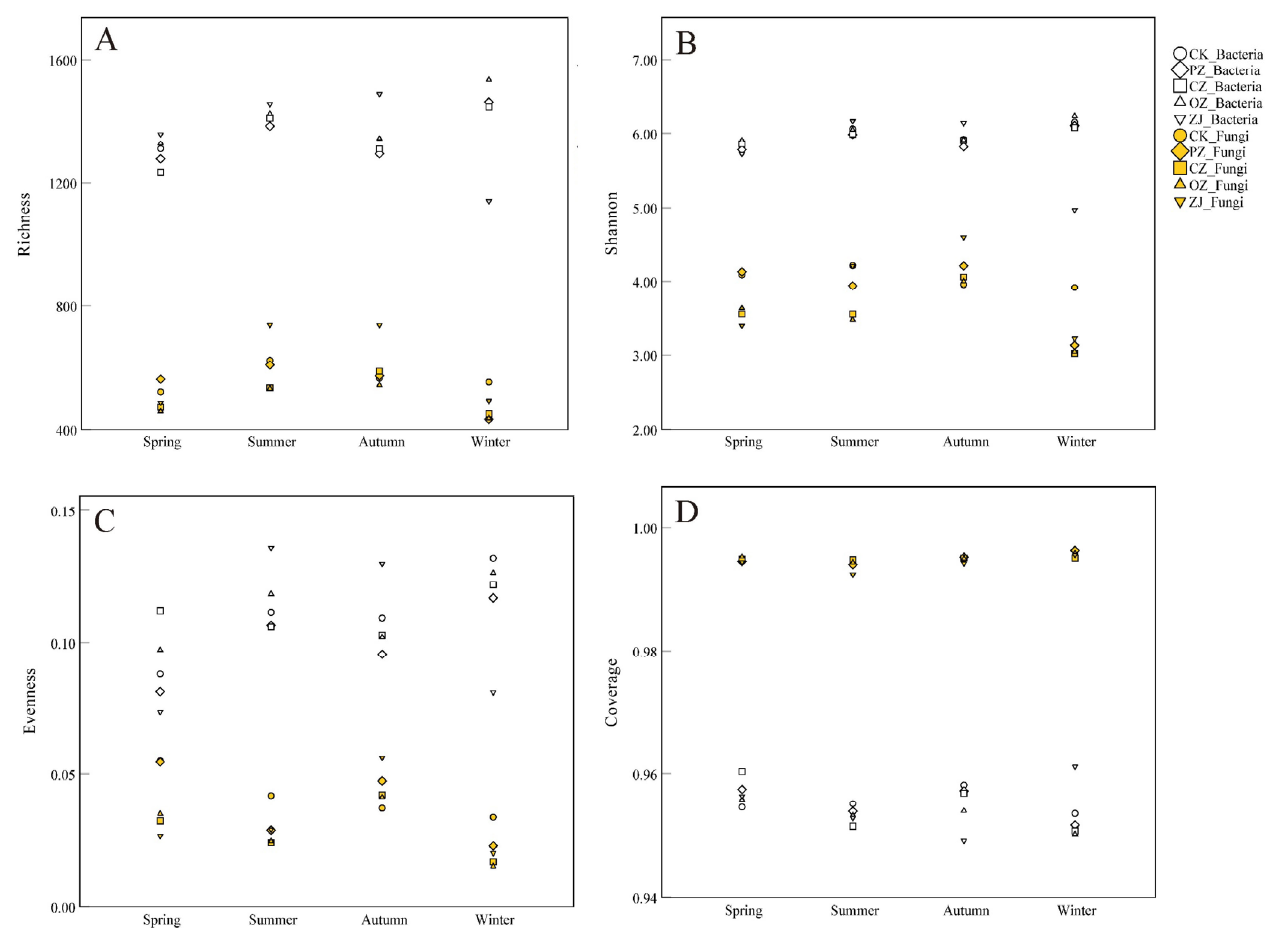
Figure 2. Diversity indices of soil microbial communities. ( A ) OTU richness index; ( B ) Shannon index; ( C ) Community evenness; ( D ) Community coverage. CK: control; PZ: C . heterophylla ; CZ: C . kweichowensis ; OZ: C . avellane ; ZJ: C . heterophylla × C . avellane .